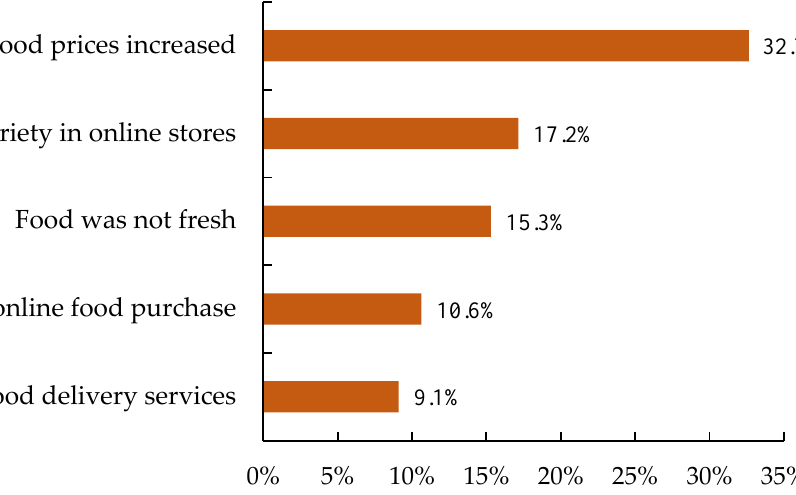
Figure 3. Problems of online food purchase during the pandemic period. Source: Authors’ own compilation.